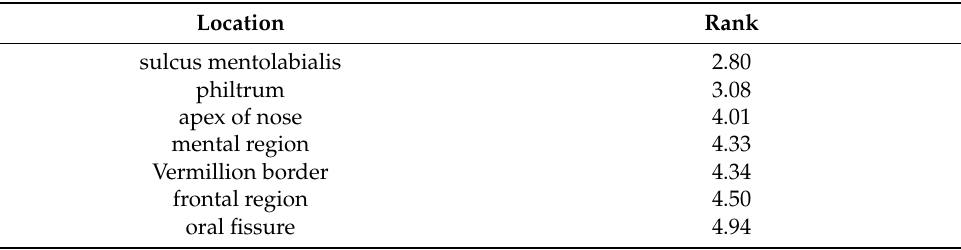
Table 3. The comparison of seven locations visible from side view of overlapped scans using Friedmann’s test. The locations are arranged from lowest to highest